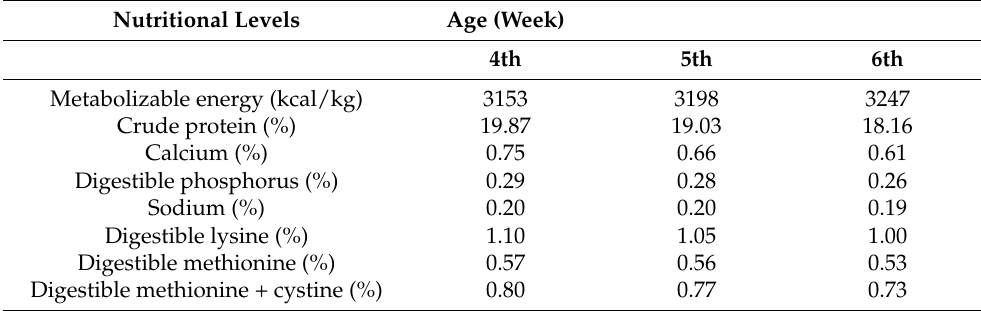
Table 1. Nutritional levels * of diets according to bird age. Nutritional